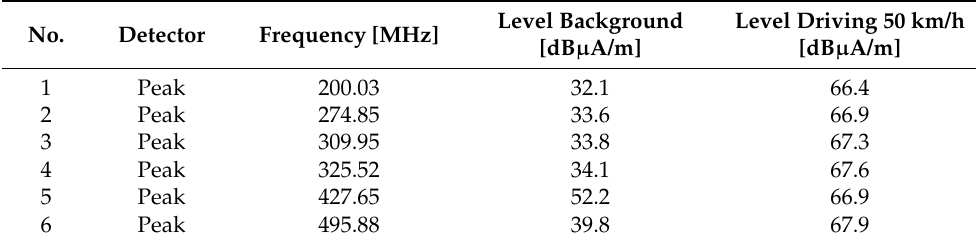
Table 6. Measurement method and results were obtained for individual frequencies, for a rail vehicle travelling at a speed of 50 km/h and the electromagnetic background.